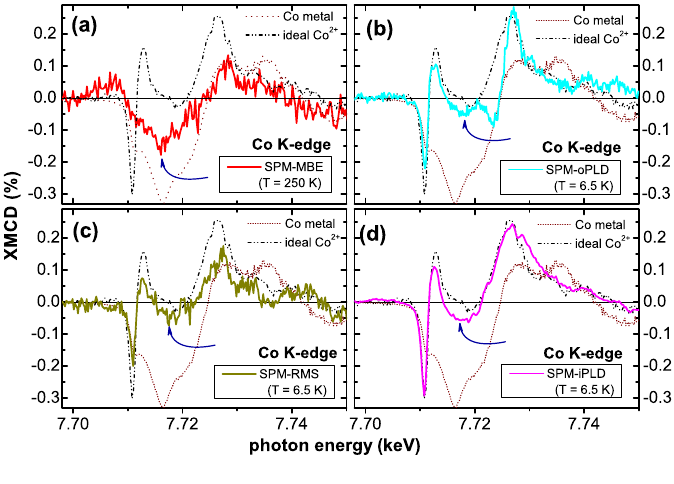
Figure 12. XMCD spectra recorded at the Co K -edge applying ± 6 T in the film plane of (a) the SPM-MBE sample at 250 K. XMCD spectra recorded at 6.5 K are shown for (b) the SPM-oPLD, (c) SPM-RMS, and (d) of the SPM-iPLD. In all four panels reference XMCD spectra are shown for Co metal and ideal Co 2+ (the PM-oPLD). The arrow marks the maximum of the XMCD of Co